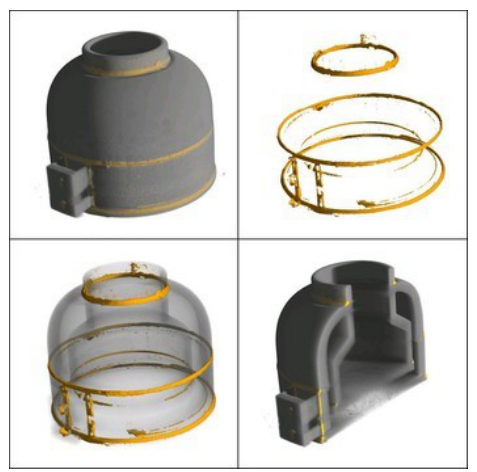
Fig. 2. Example image of assessment of soldering quality, semi-transparent 3D representation highlighting the Boron containing brazing solder distribution.